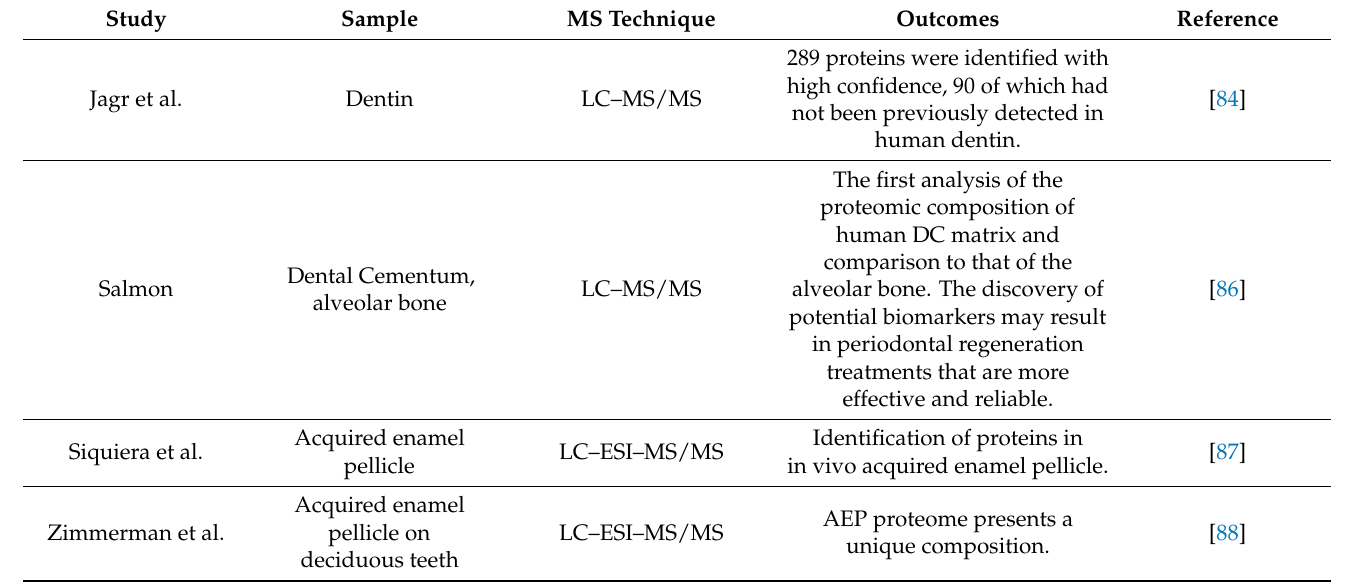
Table 3. Use of MS techniques in the investigation of hard and soft dental